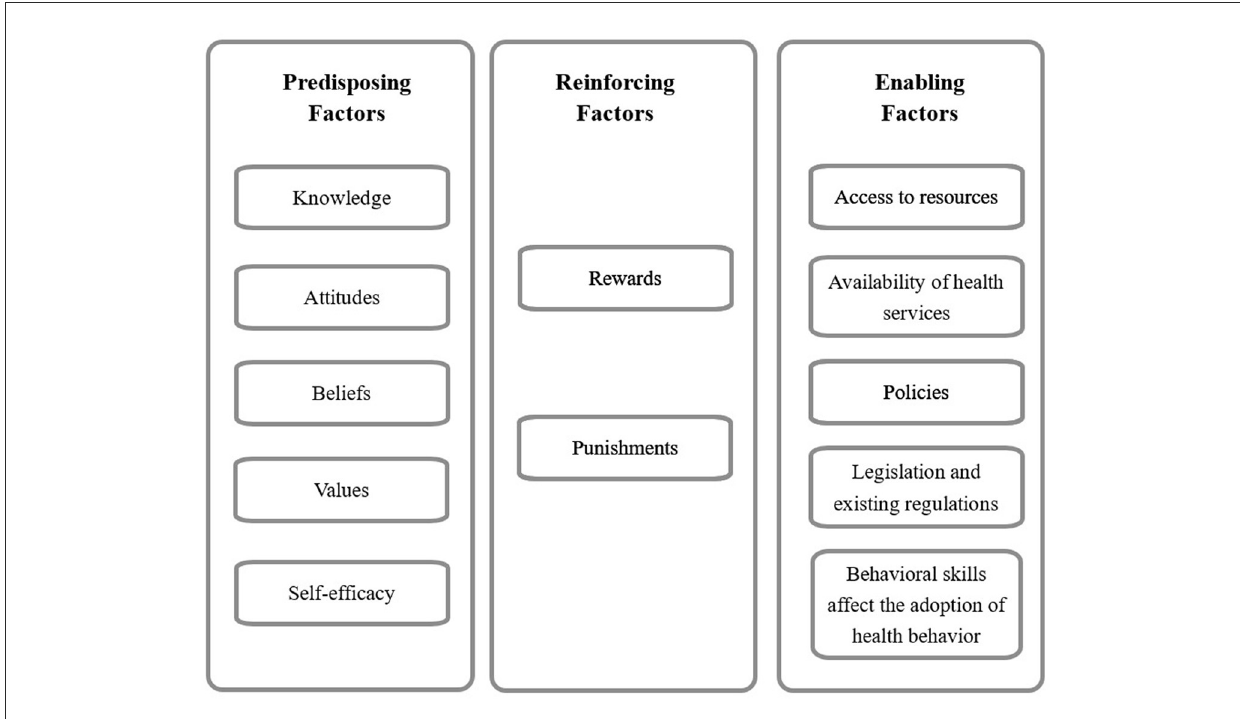
FIGURE1 Factors of occupational low back pain prevention